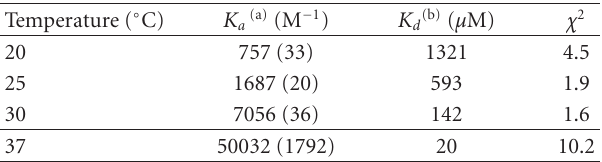
Table 1: CLP-A/HSA equilibrium binding constants determined from SPR sensorgrams.